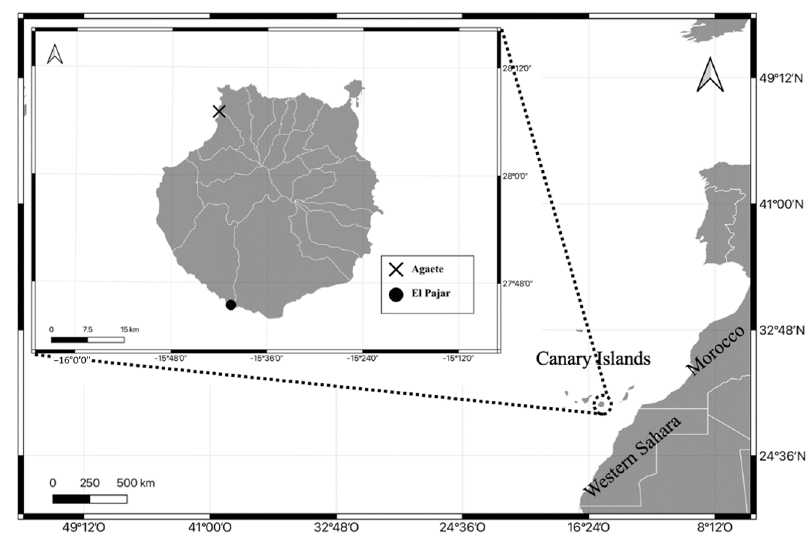
Figure 1. Map of the island of Gran Canaria with the localities selected in the study